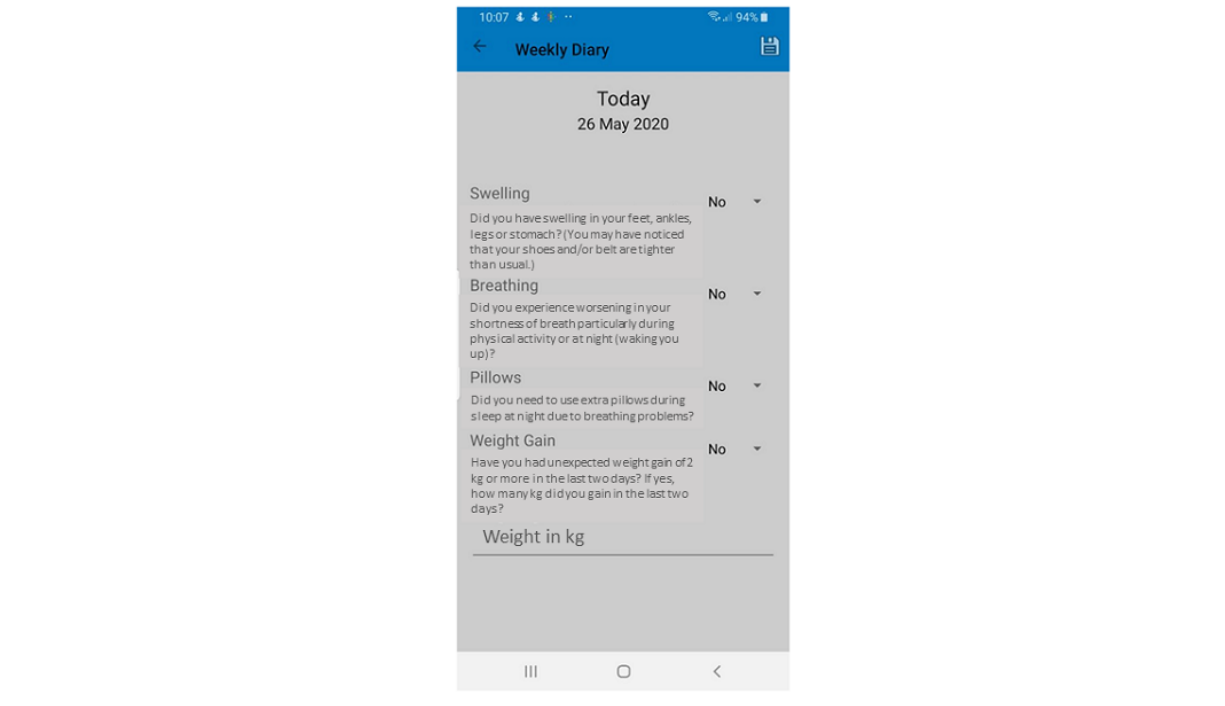
Figure 4. Weekly